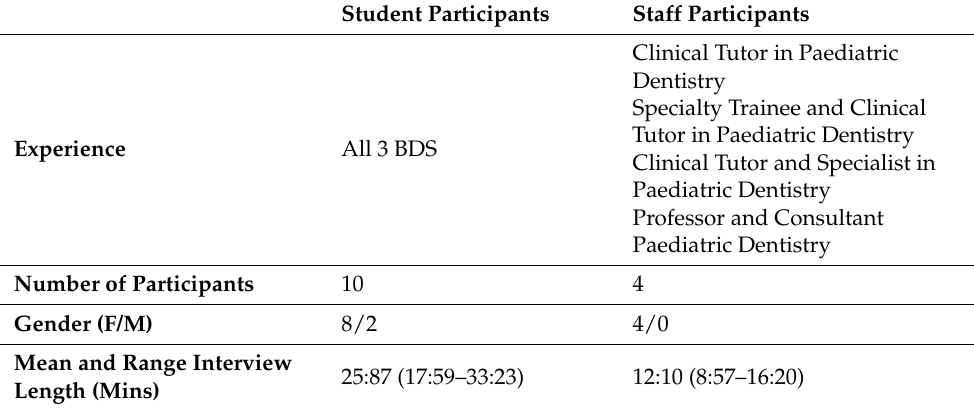
Table 1. Participant and Interview Characteristics. Student Participants